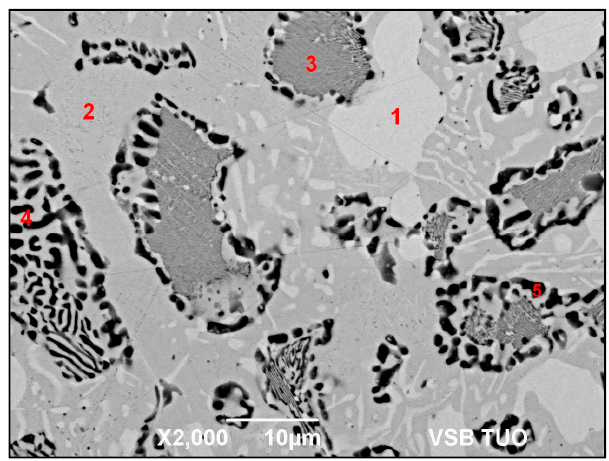
Figure 6. Microstructure of Zn6Al6Ag solder.